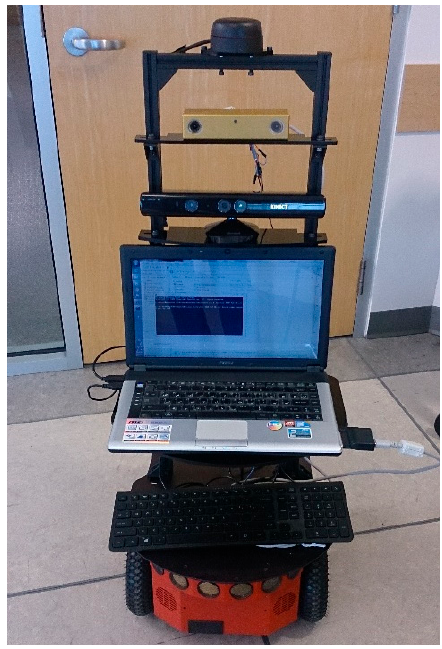
Figure 5. Pioneer P3-DX mobile robot with mounted sensors.